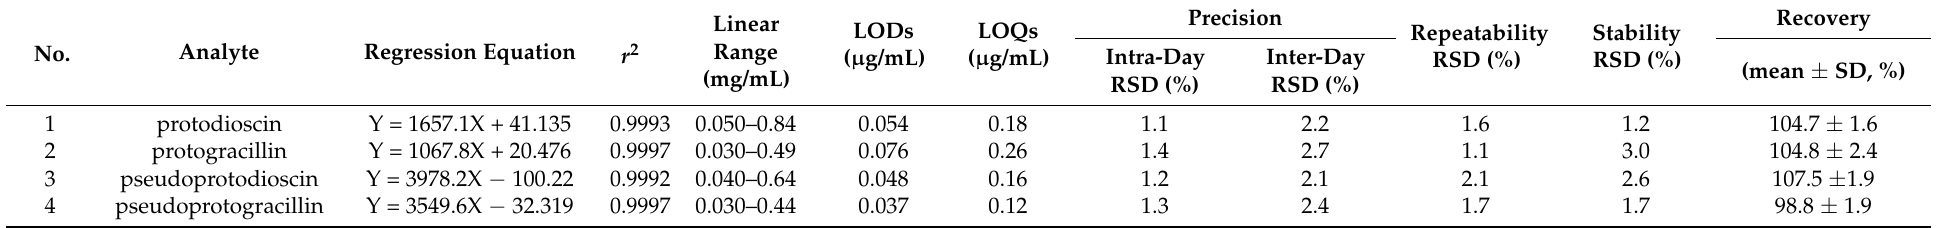
Table 1. Regression equation, limit of detections (LODs), limit of quantifications (LOQs), precision, repeatability, stability, and recovery of four bioactive steroidal saponins.